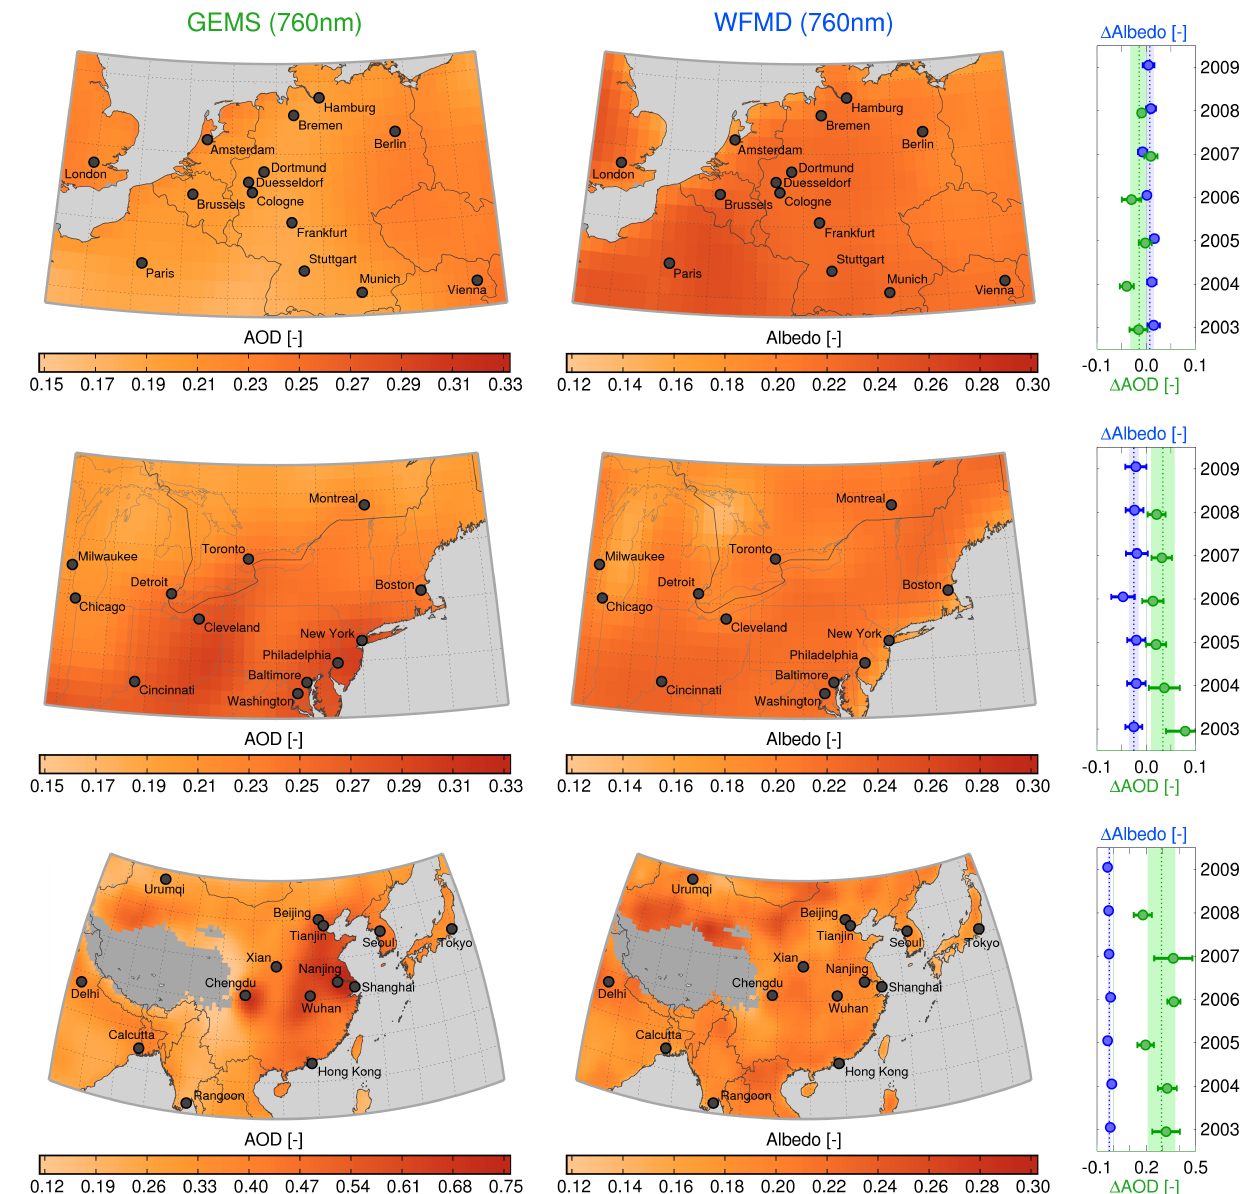
Fig. 3. Aerosol optical depth reanalysis data generated within the European GEMS project (left) and retrieved albedo at 760nm (middle) for the considered regions to analyse potential contributions of aerosol and albedo to the retrieved XCO 2 enhancement over the selected source regions. The symbols in the right panel represent the yearly differences of the mean values in the source and background regions introduced in Fig. 2 using the root sum square of the corresponding standard deviations as error bars. The dotted lines represent the average of all years and the shaded areas the corresponding standard